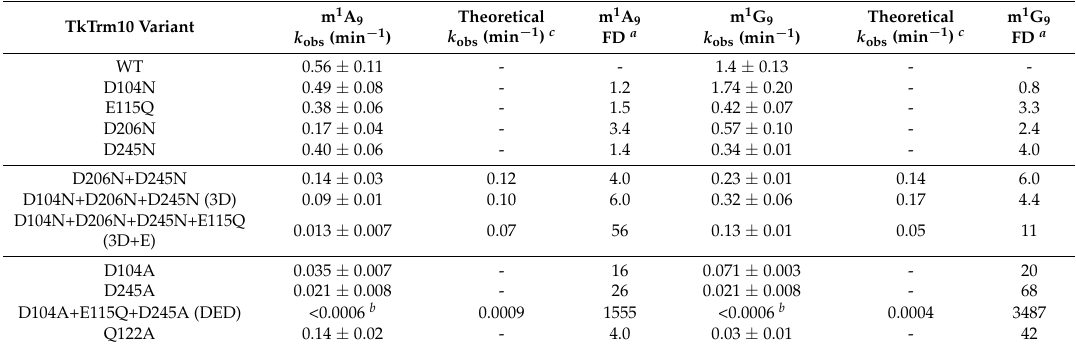
Table 2. Single turnover rates of m 1 A 9 and m 1 G 9 methylation by TkTrm10 variant enzymes. TkTrm10